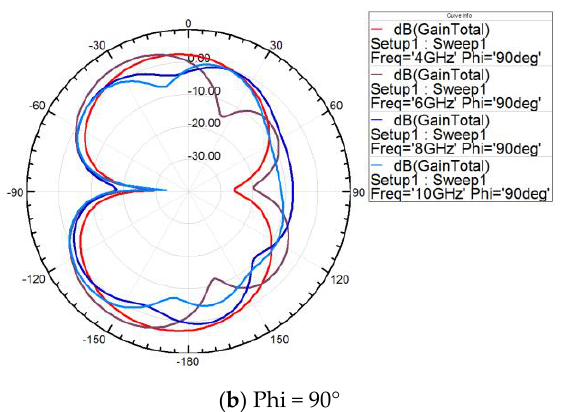
Figure 26. Circular microstrip antenna with C-SRR on the back.